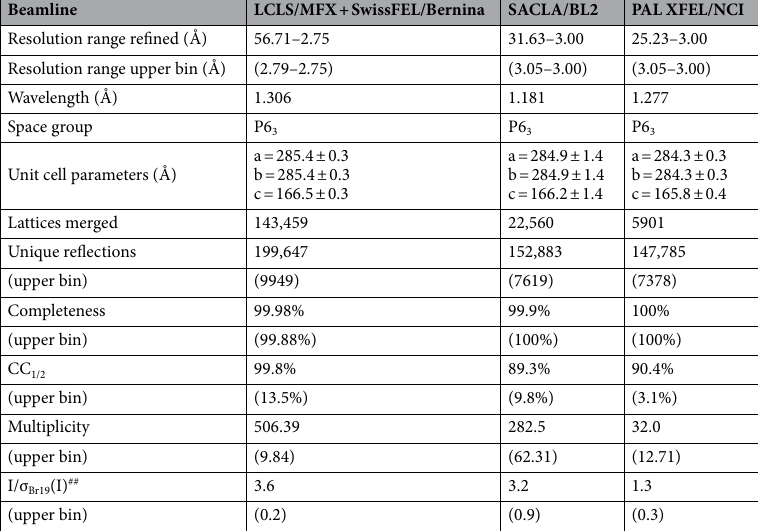
Table 1. Data processing and merging statistics PDB ID 7M75 7M78 7M76. ## : as defined in [Brewster 2019] 79 .